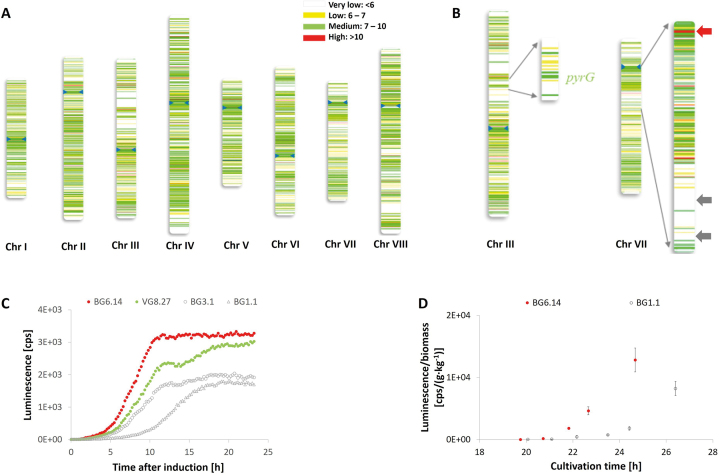
The transcriptomic landscape of A. niger. (A) Chromosomal expression values expressed as log2 mean from 155 cultivation conditions. Blue arrows indicated centromere position on each chromosome (3). (B) Selected chromosomal positions in chromosome III and VII for in vivo verification. Red arrow indicates position of chosen integration site at high level expression locus, and grey arrows indicate positions of chosen integration sites at low level expression loci. (C) Data for luciferase activity measured by luminescence in counts per second (cps) over time after induction in hours in microtiter plates. Data for strains expressing luciferase at the locus An11g08480 (‘low gene expression locus’; strain BG1.1), An11g07580 (‘low gene expression locus’; strain BG3.1), An12g03570 (‘medium gene expression locus’, pyrG, strain VG8.27), and An11g11310 (‘high gene expression locus’; strain BG6.14) are given. Doxycycline was added 16 h after inoculation. (D) Cultivation of strain BG1.1 and BG6.14 in 5L bioreactors. For each strain, two batch cultivations were performed; one was induced with 5 μg/ml doxycycline at a dry biomass concentration of 2 g/kg. Cultivation in the presence of doxycycline mediated gene expression as demonstrated by increased luminescence after induction measured in technical quintuplicate.